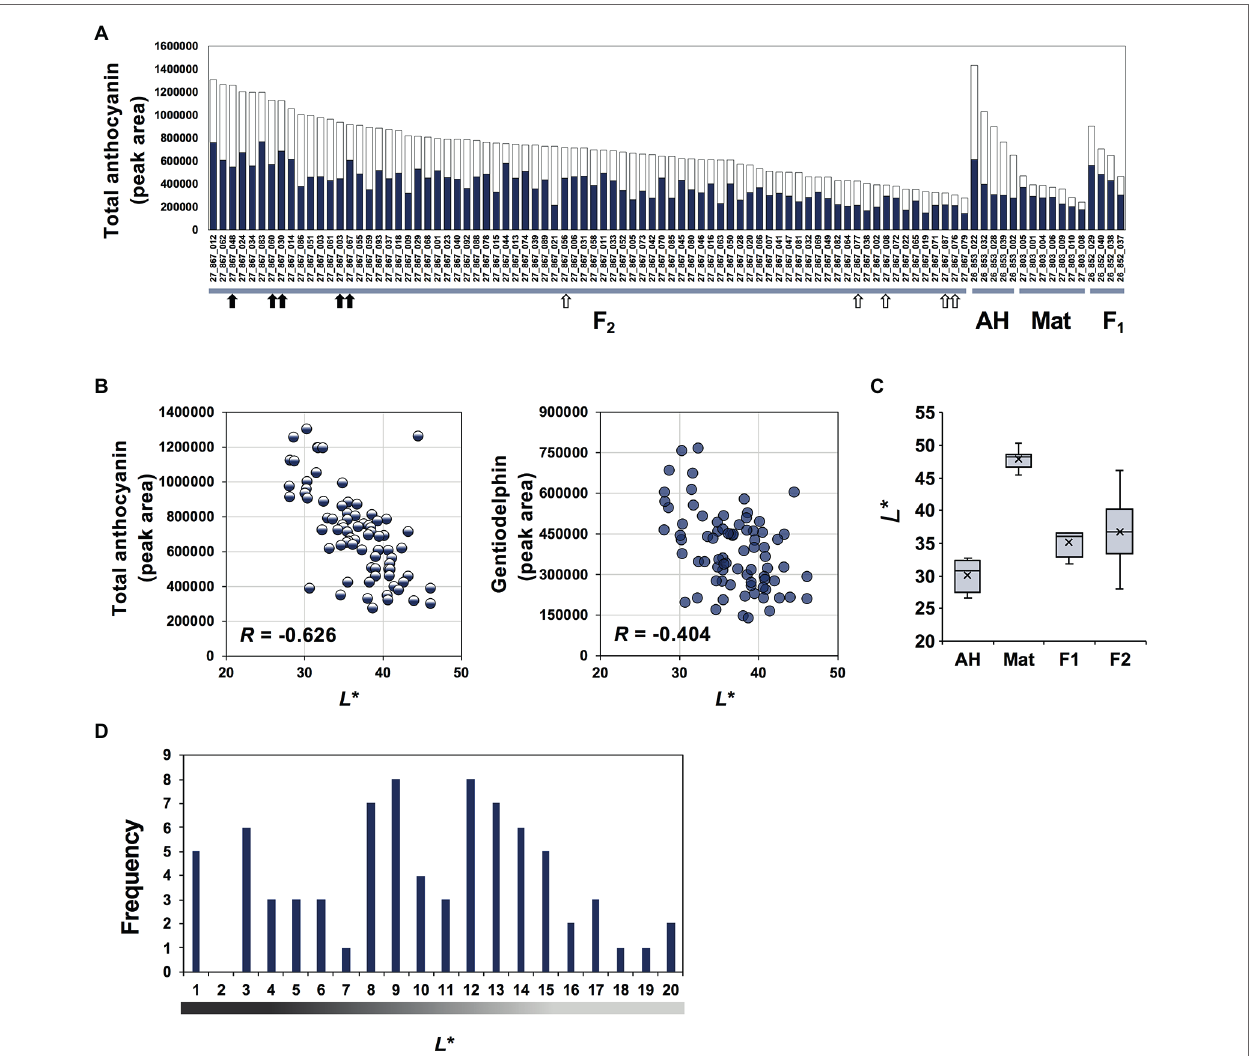
FIGURE 2 | Anthocyanin content and L * values for parents, F 1 and F 2 progeny. (A) Total anthocyanin content estimated from high-performance liquid chromatography peak area. Five AH, seven Mat, four F 1 progenies 26-852 (AH × Mat), and 78 F 2 progenies 27-867 are shown. Bar colour indicates peak areas of gentiodelphin (blue) and other anthocyanins (white). Black and white arrows indicate lines of the intense- and faint-blue flower groups subjected to RNA-seq analysis, respectively. (B) Plots of L * values and total anthocyanin or gentiodelphin contents. (C) Box plot of L * values of parental lines, F 1 and F 2 progeny. (D) Histogram of F 2 plants. L * values representing flower colour intensity are separated into 20